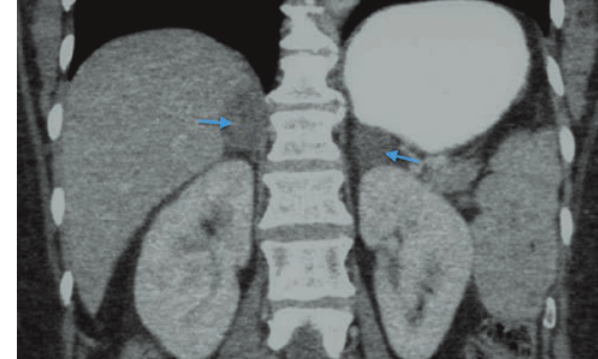
Fig. 10. A 50-year-old woman with non-Hodgkin’s lymphoma. Coronal reformatted enhanced CT scan demonstrates bilateral soft-tissue masses with preservation of the adreniform shape of the adrenal gland (blue